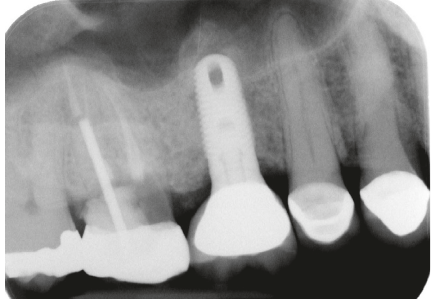
Figure 10: A periapical radiograph was taken after the implant placement. Bone condensation is noted apical to implant #3 due to the use of the osteotome sinus floor elevation technique. Mesial of #2, a deep unrestorable decay was observed.